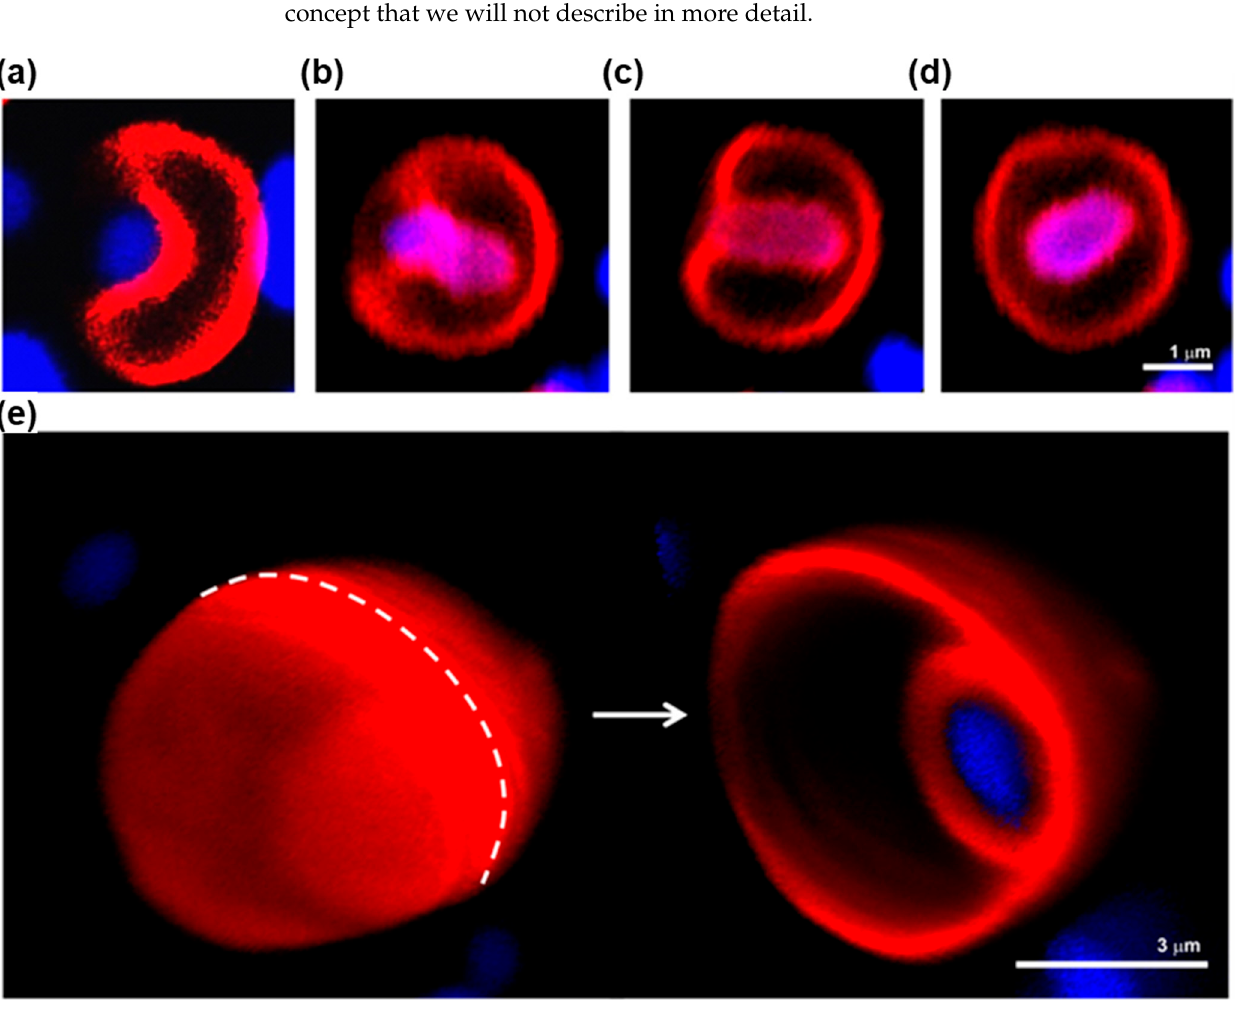
Figure 25. CLSM images show the process of engulfment of bacteria (blue) by DSs (red). ( a ) Adhesion of E. coli to the DS membrane. ( b , c ) Invagination of E. coli into the interior of the DS. ( d ) Formed endosome with living bacteria inside. ( e ) 3D reconstruction of 150 confocal scans for the whole (left) and 80 confocal scans for half (right) of the DS with engulfed E. coli . The white dashed line on a whole DS indicates the place of intersection for the presentation of half of the DS to show the interior of an endosome with engulfed bacteria [232]. The Figure was adapted from [233]. Copyright © 2019, American Chemical Society.